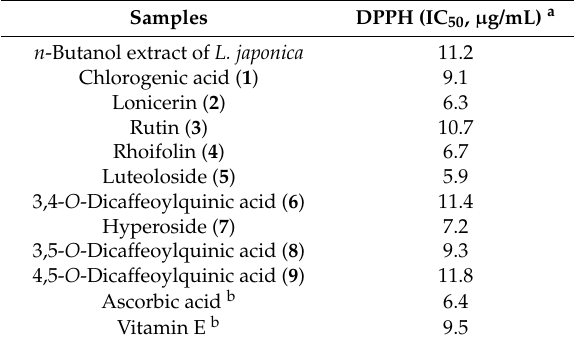
Table 1. Antioxidant activities of crude extracts and nine isolated compounds from leaves of L. japonica in DPPH assay.